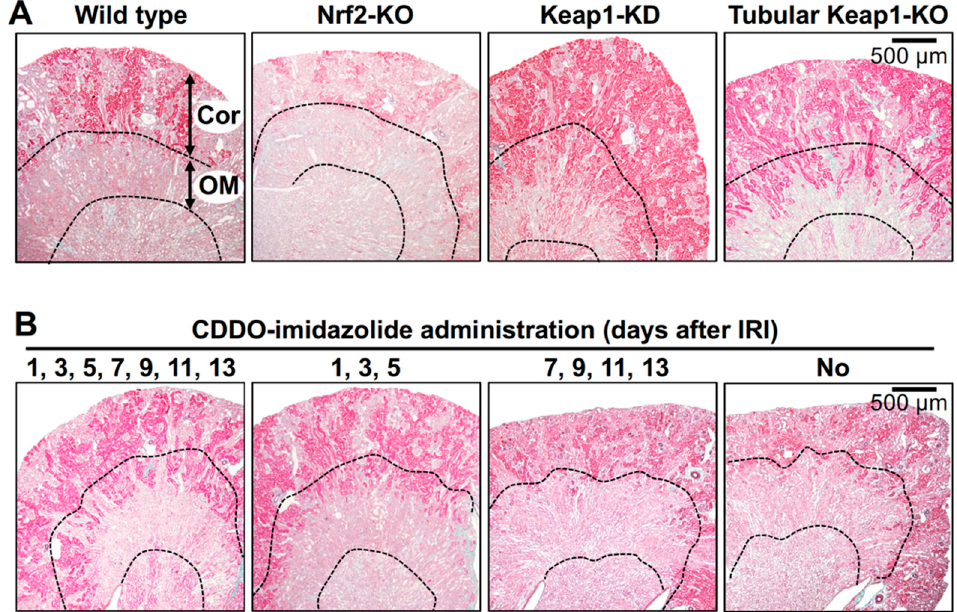
Figure 3. Impact of genetic and pharmacological modification of Nrf2 activity on kidney damage caused by IRI. Elastica-Masson staining of mouse kidney sections 14 days after renal IRI surgery distinguishes damaged renal tubules (pale pink) from undamaged renal tubules (deep pink) [67]. ( A ) In the outer medulla (OM), most tubules in wild-type and Nrf2-KO mice are damaged, while those in Keap1-KD and adult-onset, tubule-specific, Keap1 knockout (Tubular Keap1-KO) mice are well preserved. In the renal cortex (Cor), the damaged area is expanded in the Nrf2-KO mouse compared to that in the wild-type mouse. ( B ) The Nrf2 activator CDDO-imidazolide (30 µmol/kg body weight) was orally administered on the indicated days after renal IRI surgery, and kidney samples were obtained 14 days after the surgery. Notably, the data indicate that CDDO-imidazolide treatment in the early stages (1, 3 and 5 days) but not the later stages (7, 9, 11 and 13 days) after surgery is effective for renoprotection [67].